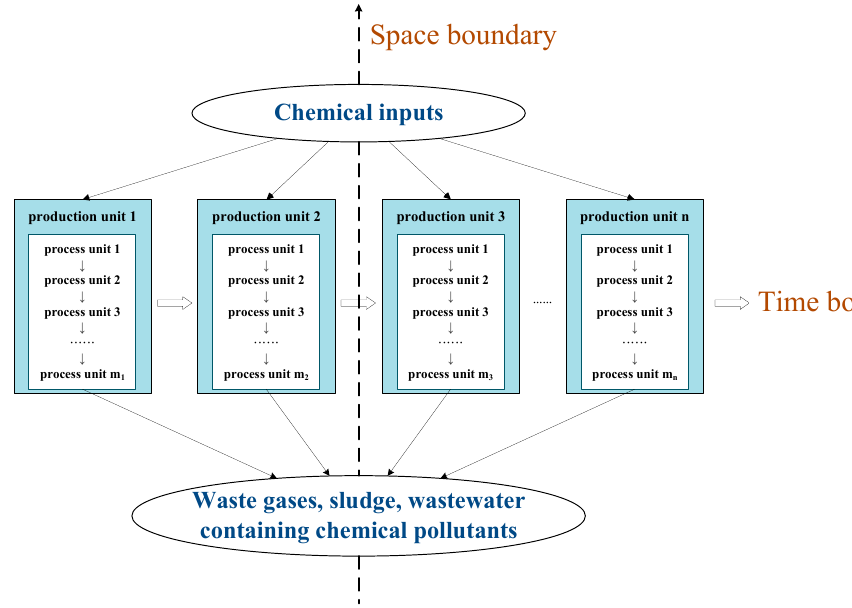
Figure 2. Modular model for hierarchical product chemical footprint calculation.